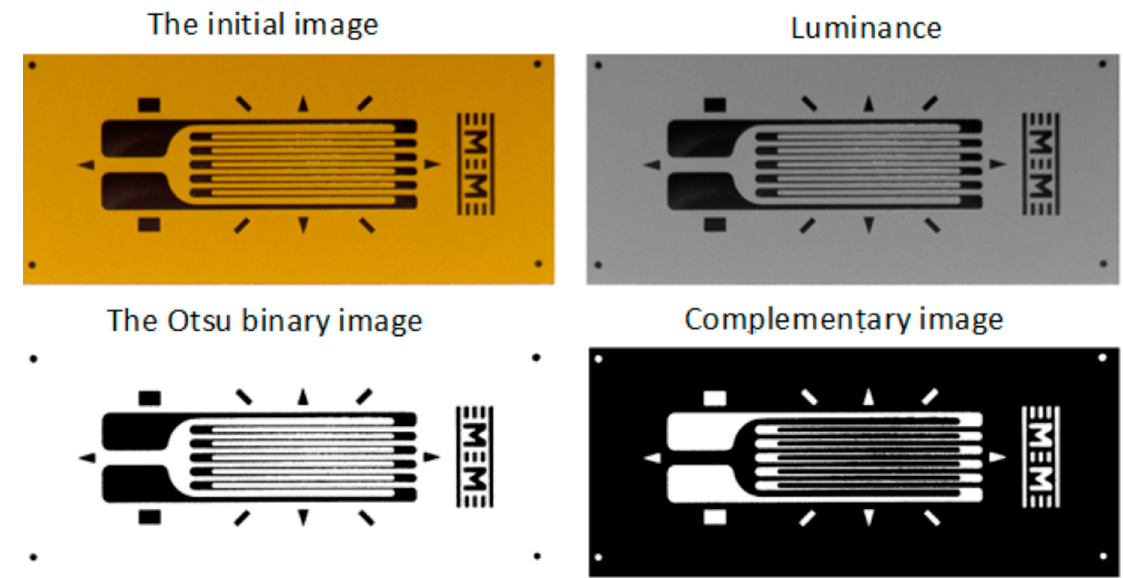
Figure 8. Obtaining the binary image for the type 1 transducer (step 3).